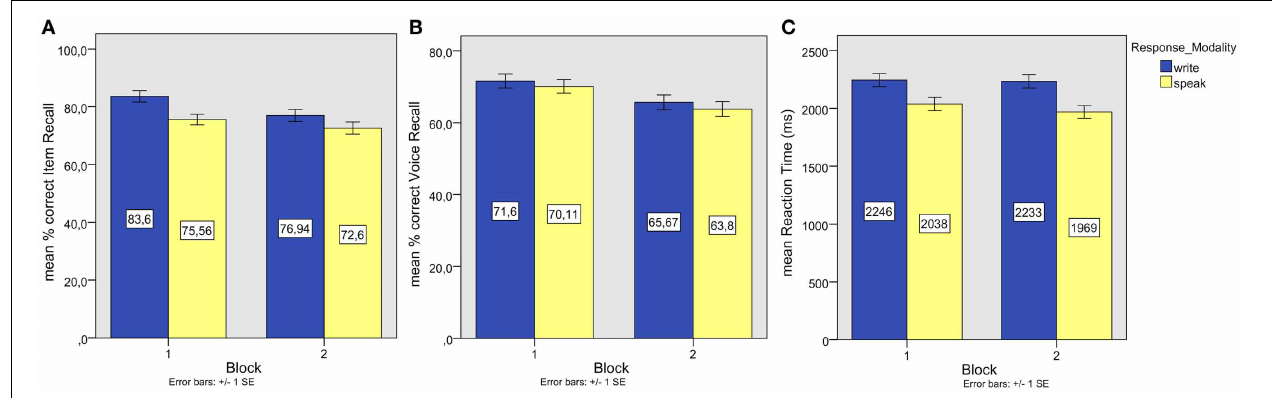
FIGURE 5 | Experiment 3. (A) Mean associate word (item) recall performance; (B) Mean episodic information (associate word spoken with male or female voice) recall performance; (C) Mean reaction times of correct associate word recall responses.